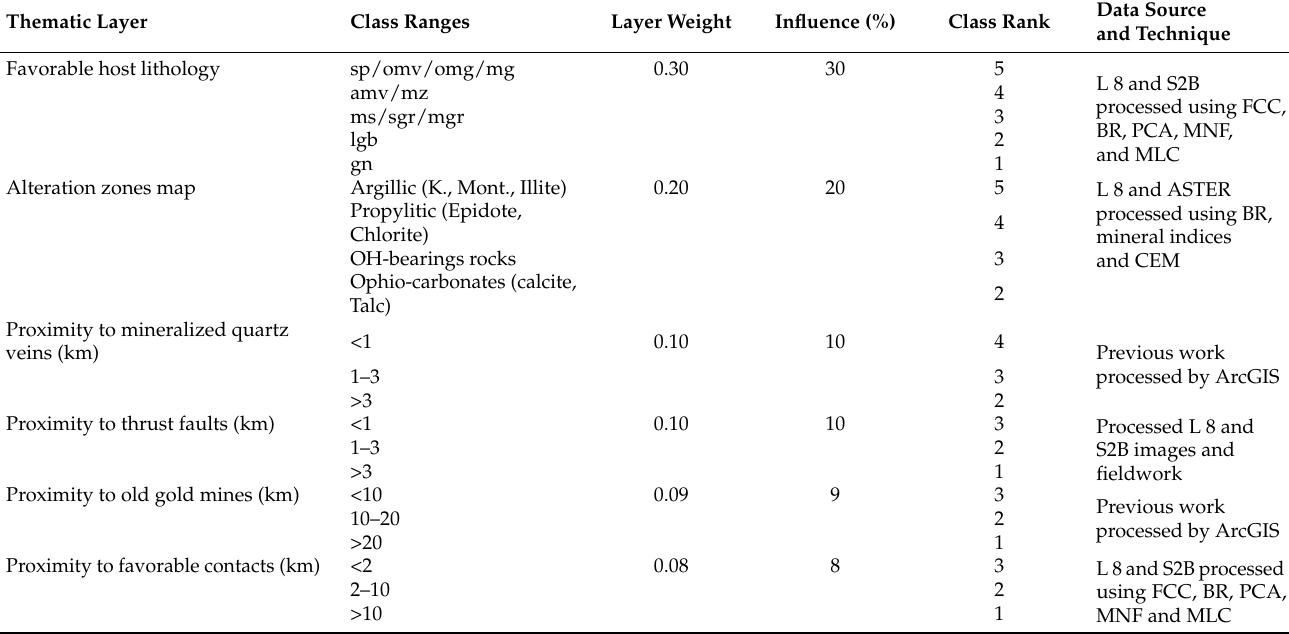
Table 6. Weights assigned for different gold mineralization parameters in the study